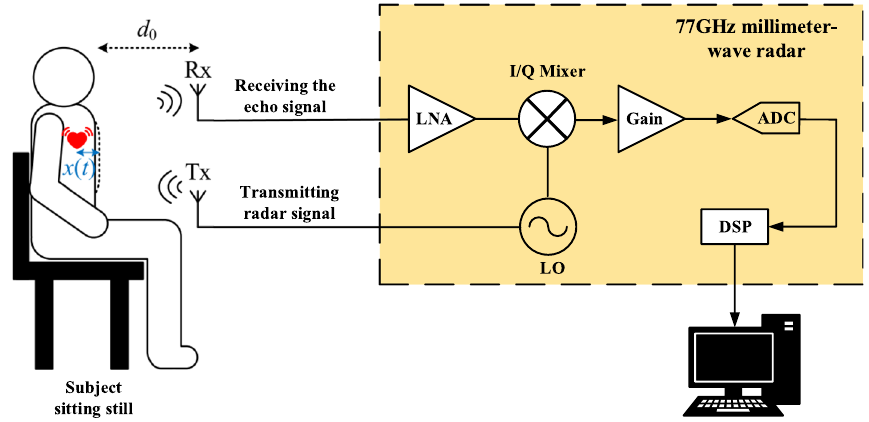
Fig. 1 77 GHz millimeter-wave radar system for heartbeat